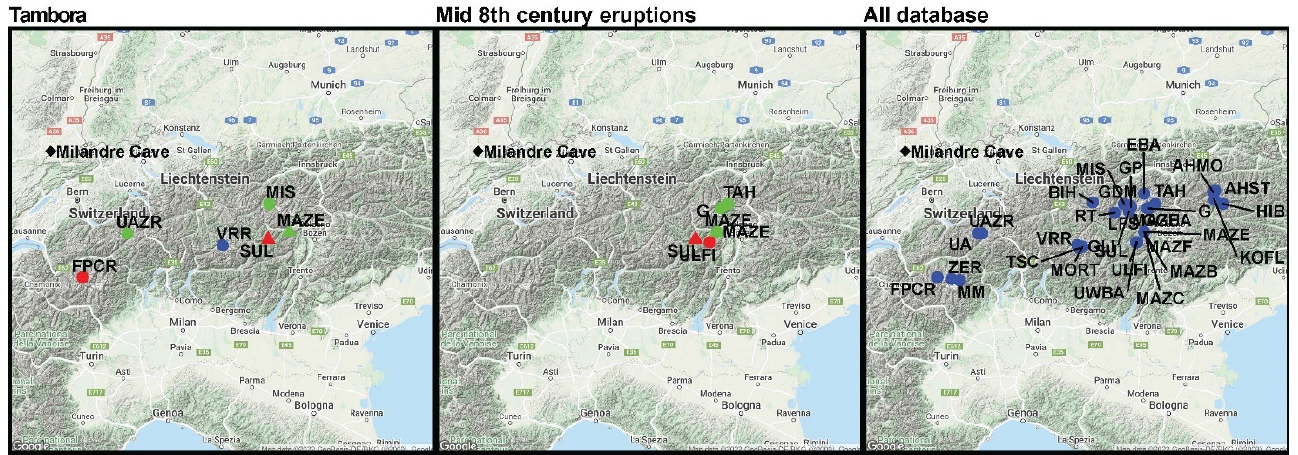
Figure 1. Sampling locations of the analysed tree and speleothem samples: Green symbols corre- spond to sites where cembran pines were collected, red symbols indicate larch samples, and blue symbols denote where samples of both species were collected. Dots indicate the sites of isotope samples with 5-year resolution, while triangles represent the sites of annually resolved isotope series. The black rhomboid corresponds to Milandre Cave, from which the speleothem record originates. Left panel: sampling sites of the trees covering the Tambora eruption. Central panel: location of the trees covering the mid-8th-century Icelandic eruptions; the site MAZE provides samples with both resolutions. Right panel: all sites of the Eastern Alpine Conifer Chronology (EACC) that provided material for the complete tree-ring isotope dataset: green = cembran pine, red = larch samples, and blue = both